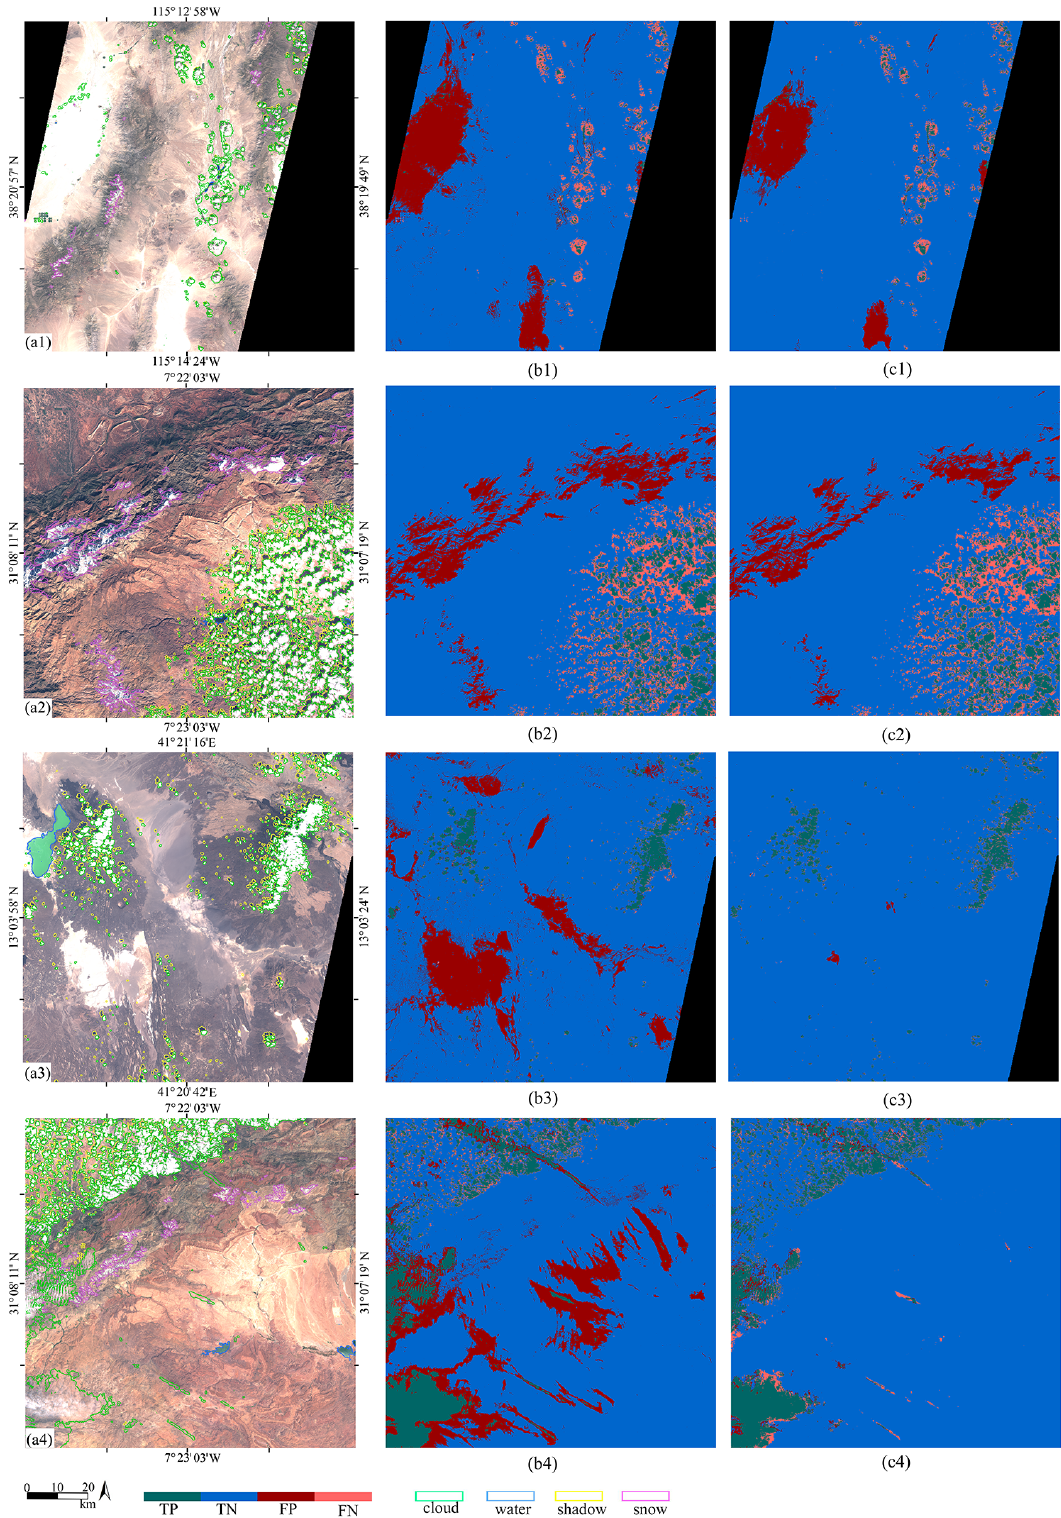
Figure 11. Cloud masks of Sentinel-2 images with bright non-cloud objects. ( a1 – a4 ): RGB composites with delineation of categories, ( b1 – b4 ): Sen2Cor cloud masks, ( c1 – c4 ): Fmask cloud